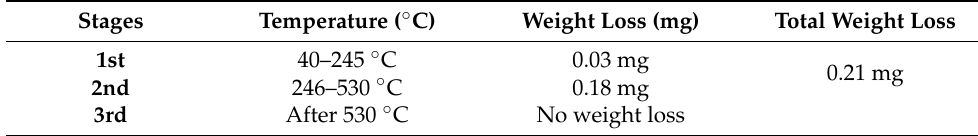
Table 3. TGA data of synthesized SnO 2 nanoparticles. Table 3 . TGA data of synthesized SnO 2 nanoparticles .